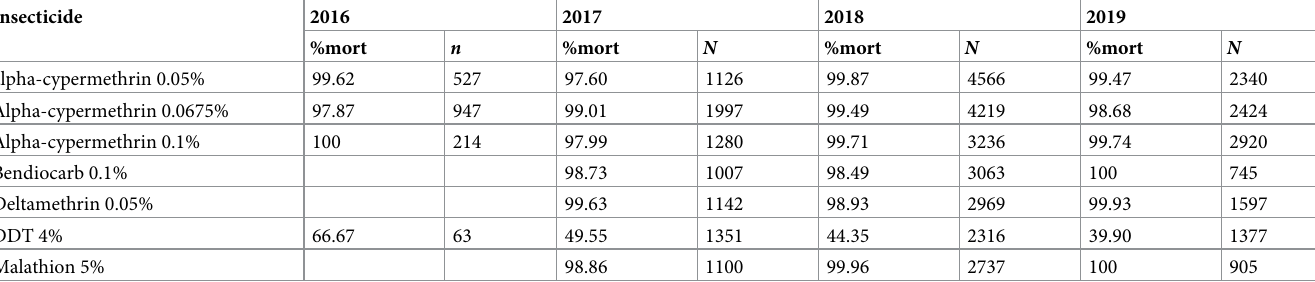
Table 1. P . argentipes mortality over time for a range of insecticides in WHO susceptibility tests.